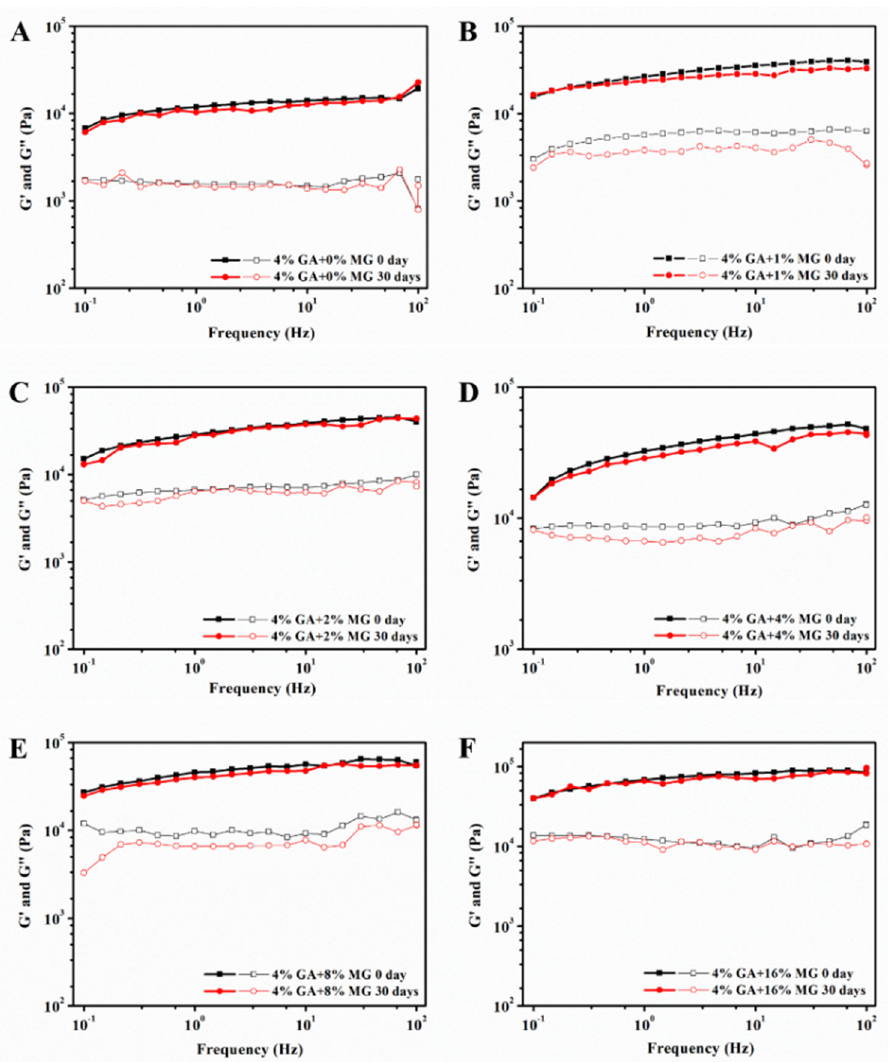
Figure 6. ( A – F ) Storage modulus (G ′ ) and loss modulus (G ″ ) as a function of frequency for dual ‐ structured gel emulsions prepared by 4 wt% GA nanofibrils and different MG concentrations (0–16 wt%), measured at initiation (0 days) and after 30 days of storage at room temperature (25 °C). G ′ and G ″ are shown as filled and open symbols, respectively. All measurements were performed at 25 °C.